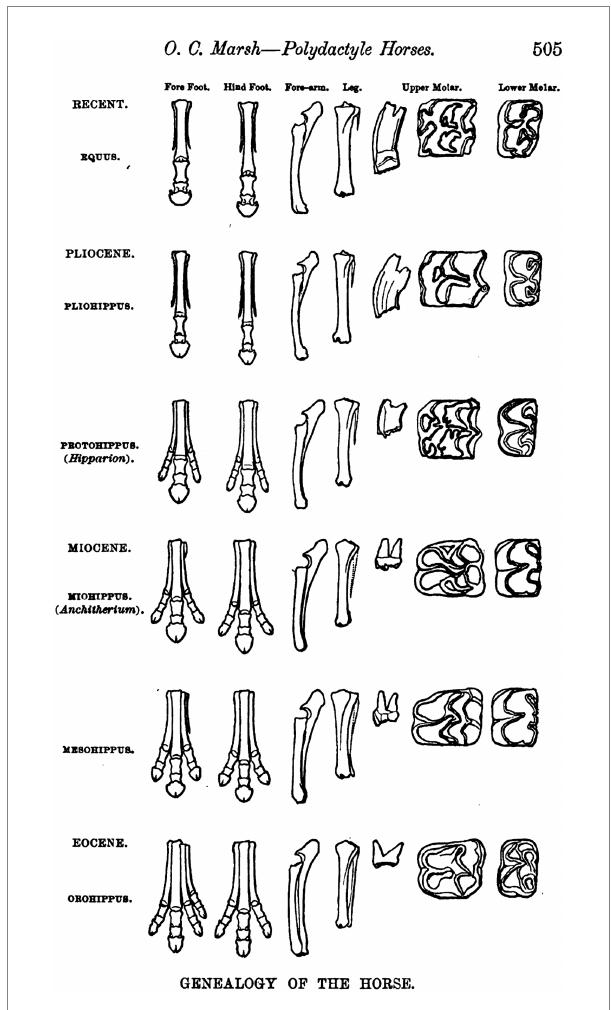
FIGURE 2 Othniel Marsh’s illustration of the “Genealogy of the Horse” in North America (from Marsh, 1879, Plate following page